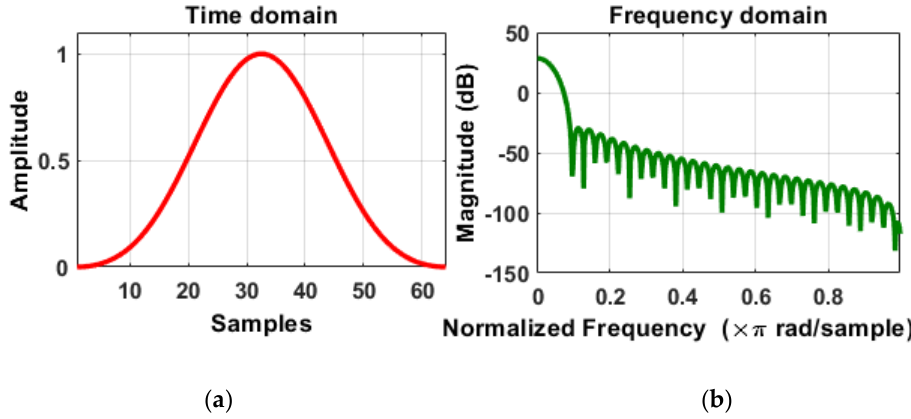
Figure 11. Blackman window in ( a ) the time domain and ( b ) the frequency domain, representing a length of 64 in the time domain.